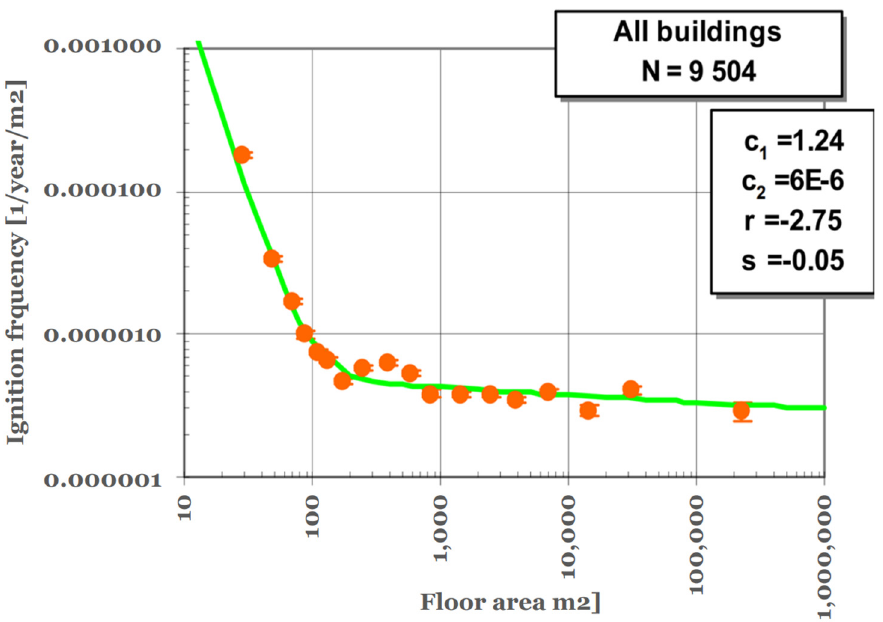
Figure 7. Ignition frequency observations (orange dots) in all building categories in Finland from 1996 to 1999 and a generalized Barrois model fitted to the data (solid green line) (extracted from [6]). Likewise, an underestimation of the ignition frequency emerges from the comparison between the Australian data and the Barrois model for office buildings, as depicted in Figure 8. Here again, a correction factor of 1.05 × 10 − 5 is used for the Barrois curve to fit the statistical data. The gap is now four times lower than in the previous case.